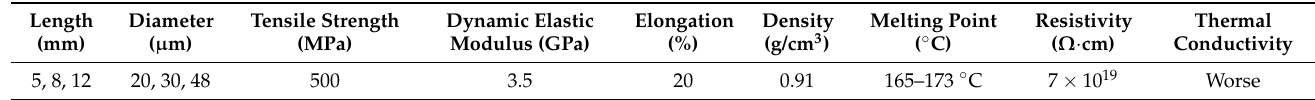
Table 1. Performance indices of modified PP fiber.